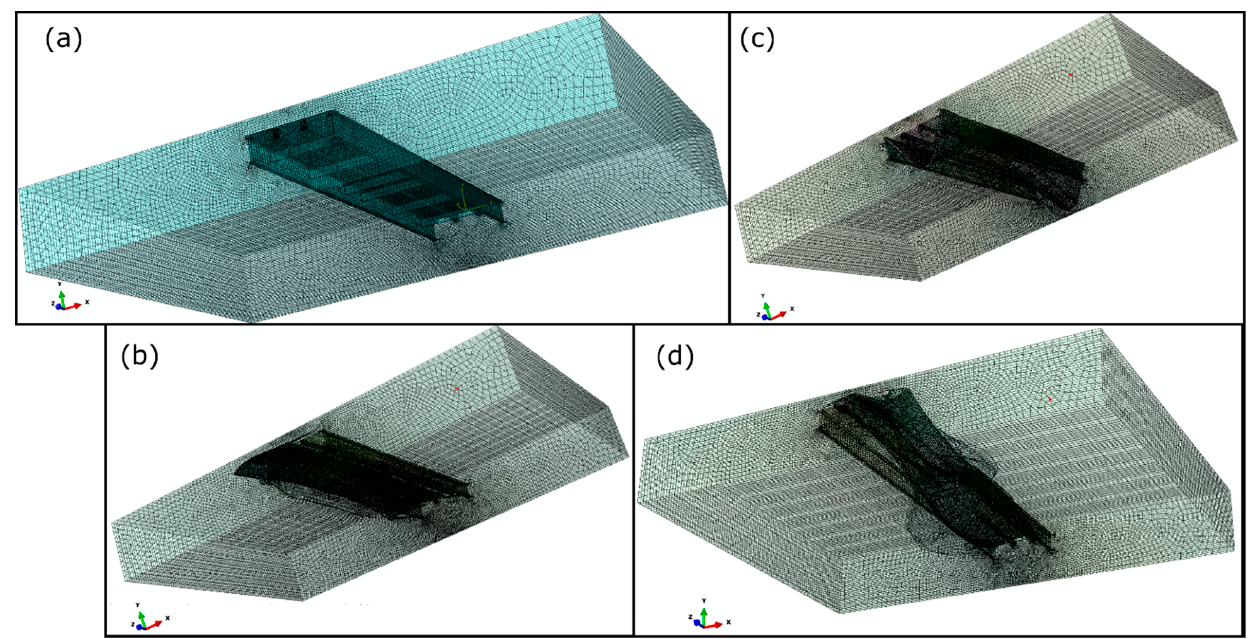
Figure 6. FEM of the full-scale bridge and its dominant modes in the semi-inundated condition: ( a ) undeformed FEM; ( b ) 1st mode shape; ( c ) 4th mode shape; ( d ) 9th mode shape.